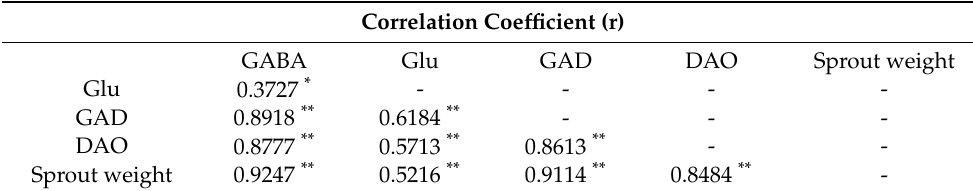
Table 3. Correlation coefficients between γ -aminobutyric acid (GABA) and glutamic acid (Glu)